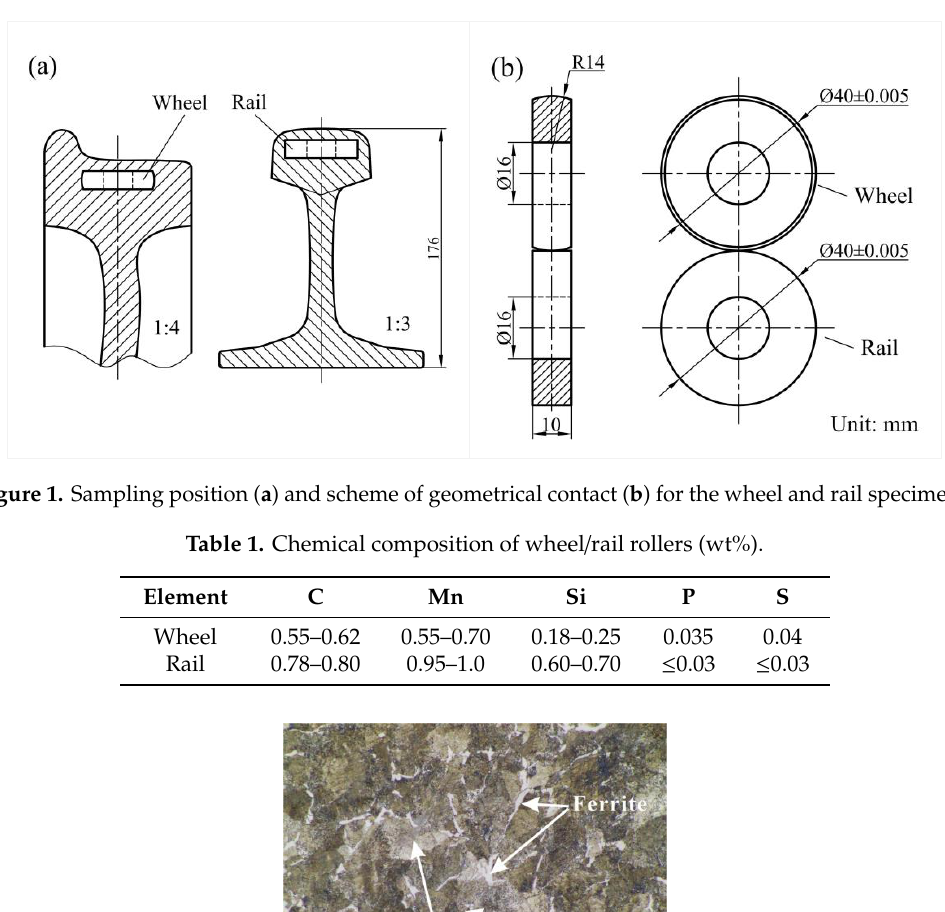
Figure 2. Microstructure of as-received wheel material. Table 1. Chemical composition of wheel/rail rollers (wt%).